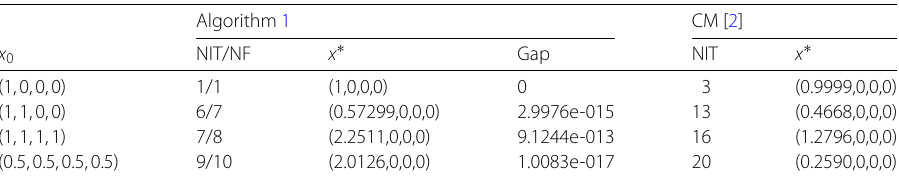
Table 6 Experimental results of Example 5 Algorithm